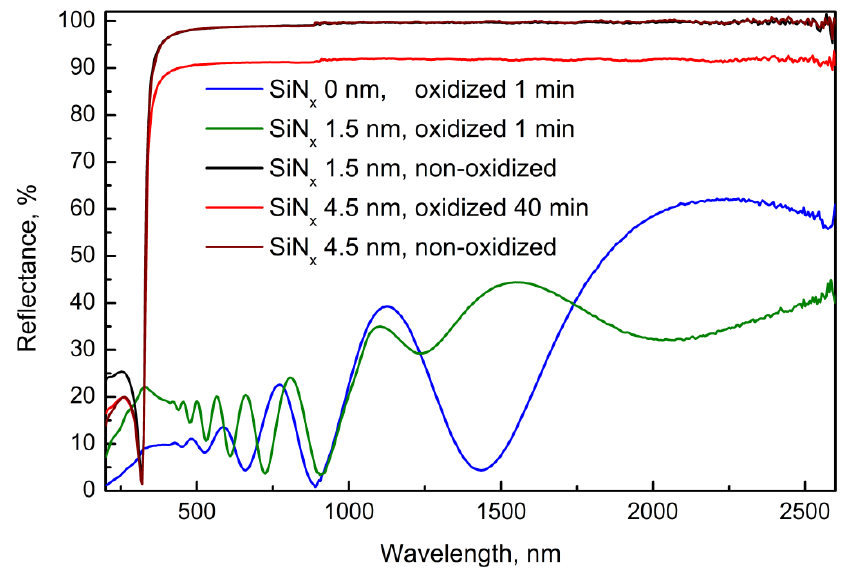
Figure 4. Reflectance of the mirrors: unprotected (SiN x 0 nm) and protected with 1.5 nm of SiN x and 4.5 nm of SiN x before (non-oxidized) and after (oxidized) plasma treatment. For the mirror with 4.5 nm SiN x protective layer, 1 min of O 2 plasma exposure does not change the reflectivity (the curves for non-oxidized and oxidized SiN x 4.5 nm layer are indistinguishable).